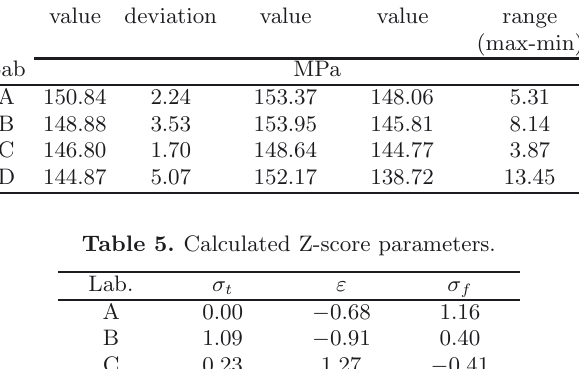
Fig. 3. Tensile strength ( σ t ) and uncertainty values for the tensile test of the participant laboratories.